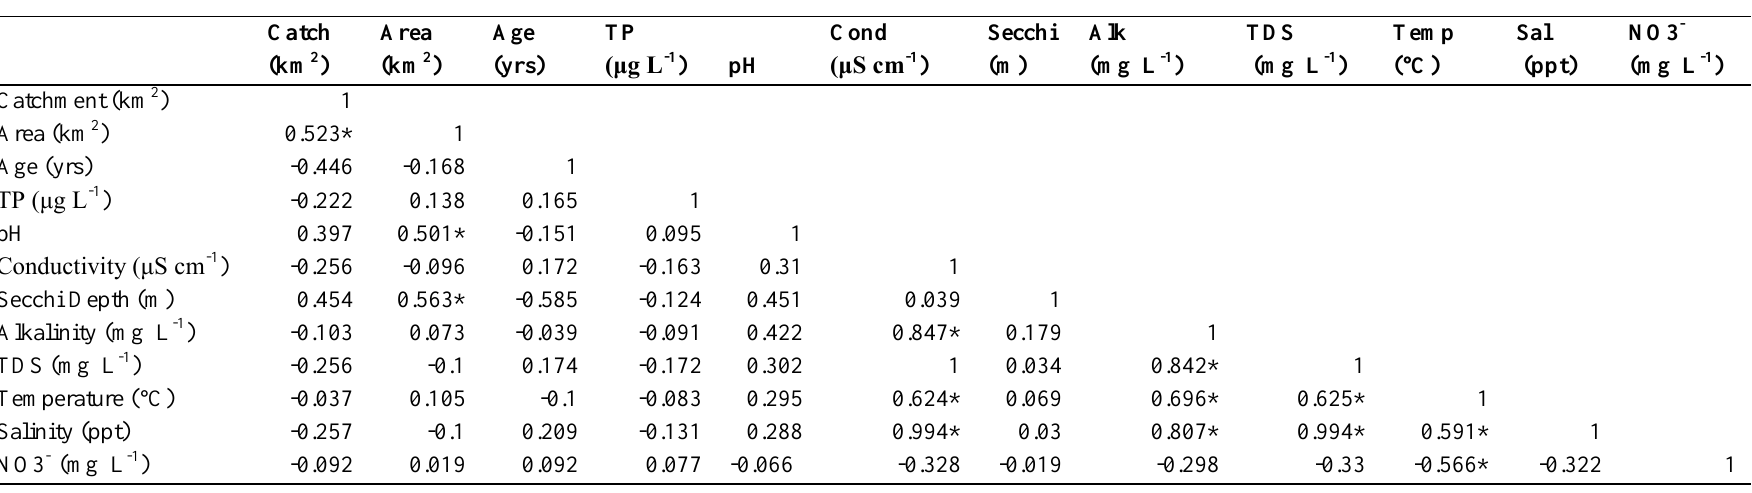
Table 2: Pearson correlation matrix on transformed environmental variables with Bonferroni adjusted probabilities for 12 environmental variables in the 45 reservoirs. * Indicates significant correlation at P <